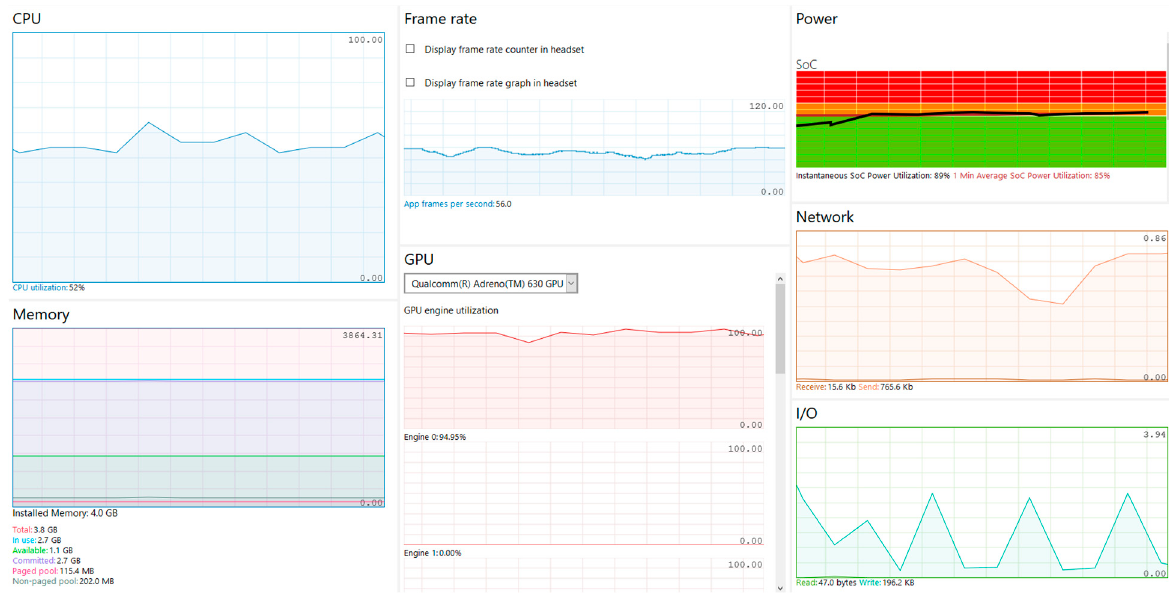
Figure 5. Screenshot of a live hardware usage of shared MR (mixed reality) visualization. As you can see, the usage of CPU (central processing unit) is at 50–60%, and GPU load fluctuates at almost 100%, with framerates fluctuating between 50–60 fps, which is sufficient for smooth application performance.